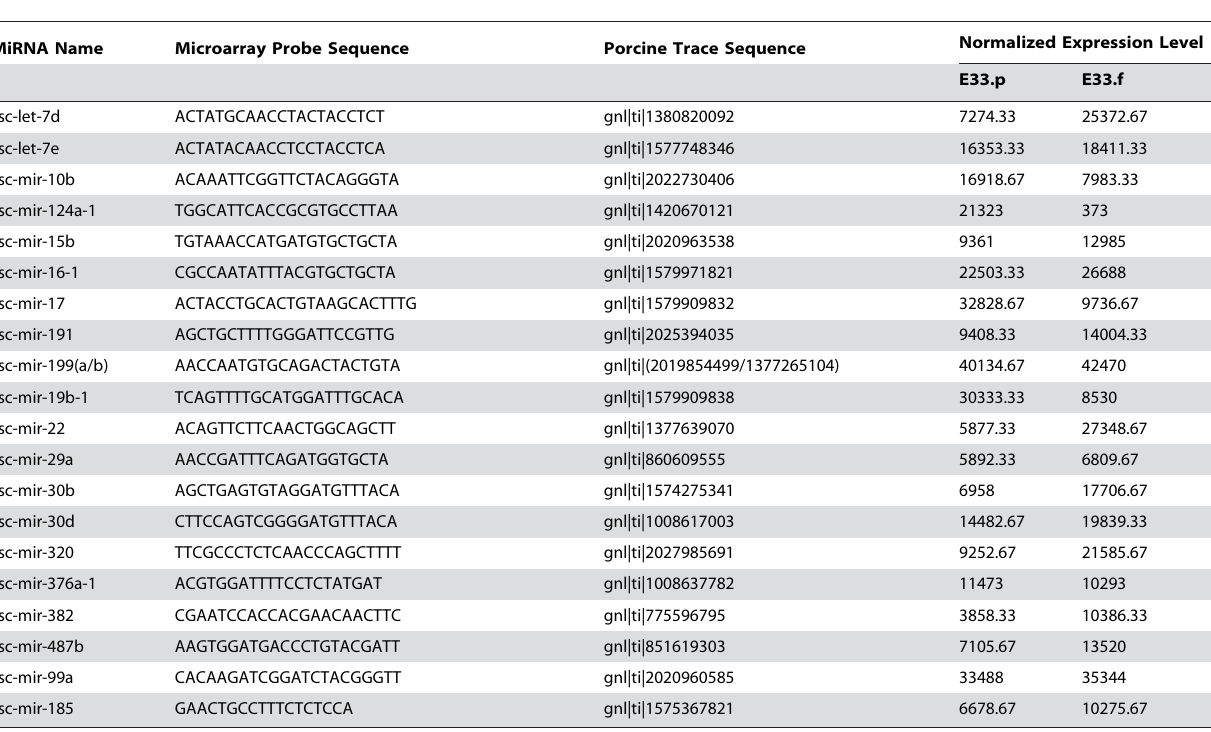
Table 1. New porcine miRNAs identified in 33 day post-gestation samples of whole embryo (E33.f) and placenta (E33.p).